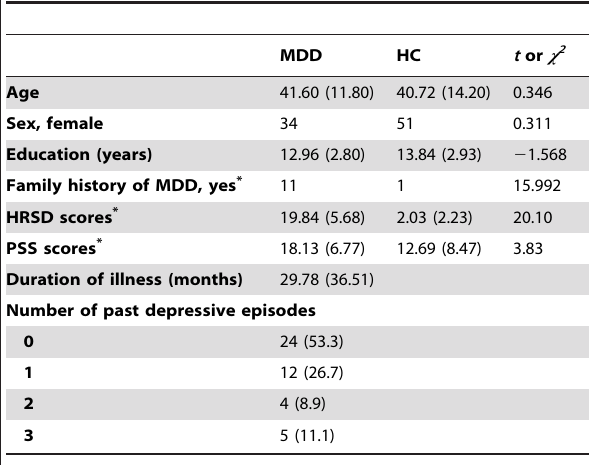
Table 2. Demographic and clinical data for patients with major depressive disorder and healthy controls.